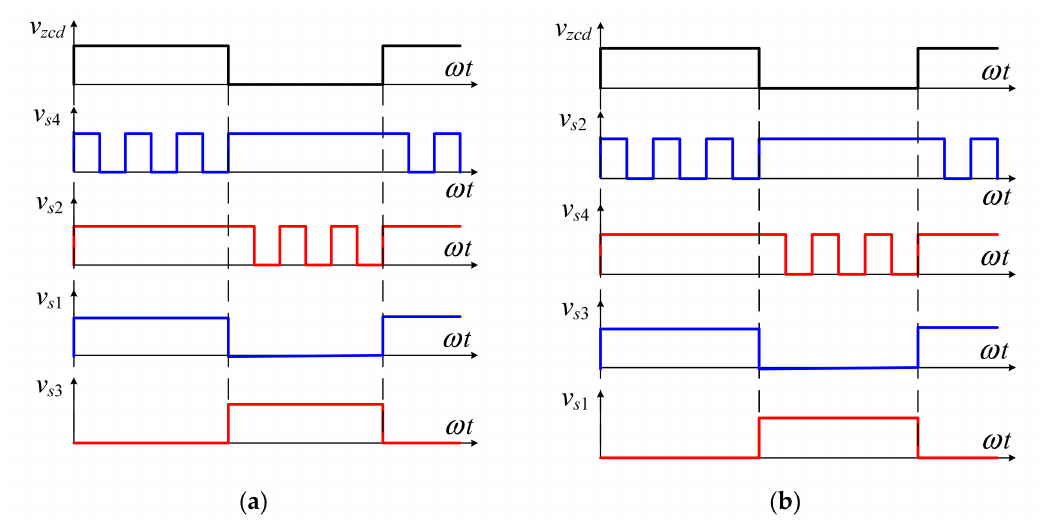
Figure 7. Switching control signals for ( a ) non-inverted output and ( b ) inverted output. The details of the power transfer from input to output are explored in the highlighted loops of Figure 8a–d when the value of the input is positive and negative, respectively.